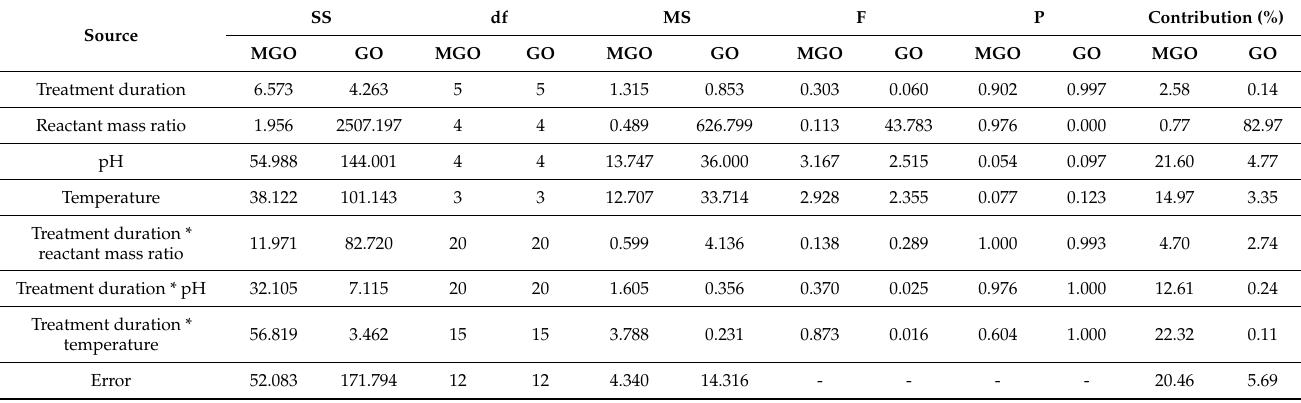
Table 1. Relative contributions 1 of factors and interactions to the effect of glycated glutenin on digestibility. Source